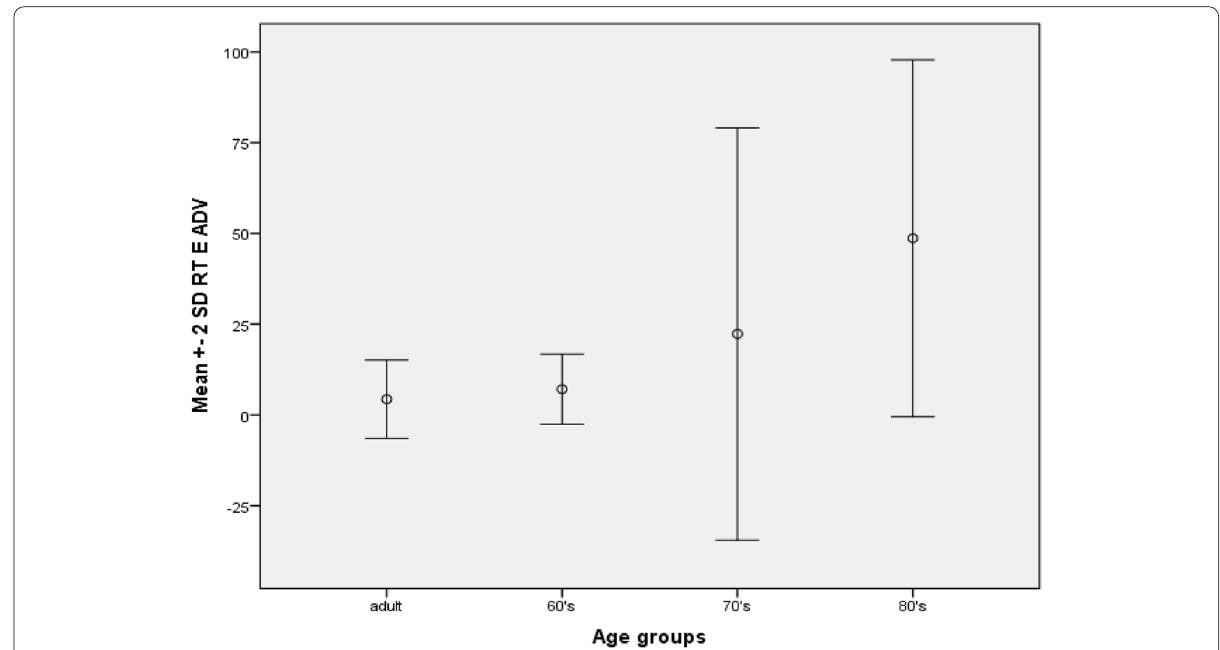
Fig. 3 Mean and SD of scores of DD test (REA) for the adult group and elderly subgroups